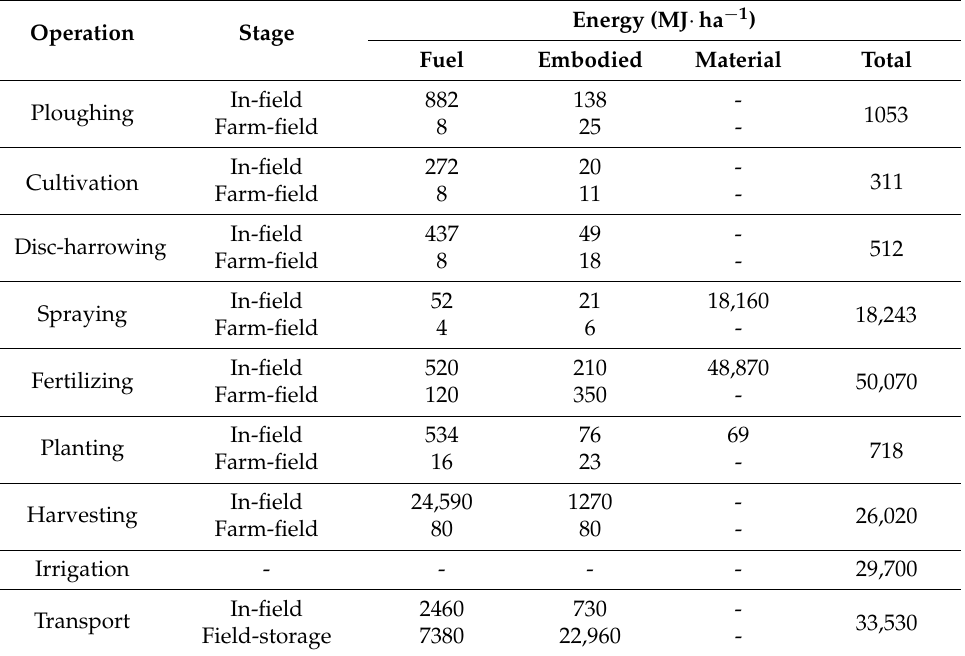
Table 4. Energy requirements for each operation in the basic